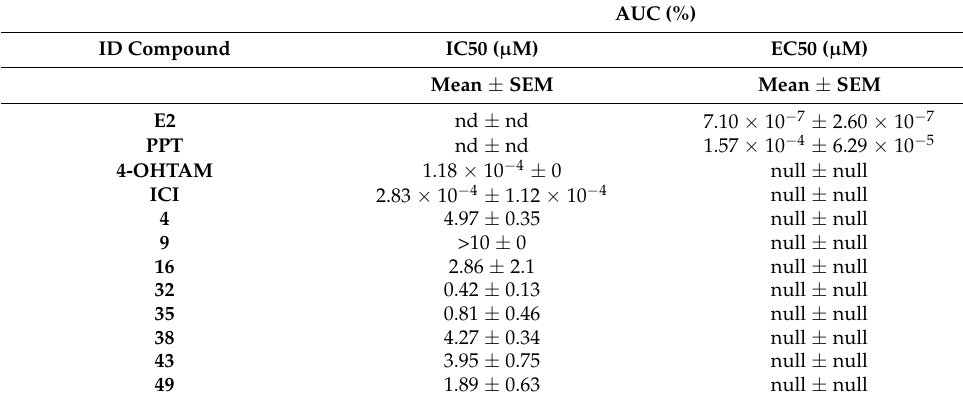
Table 4. Effects of 5-hydroxy-3,5-diaryl-1,5-dihydro-2 H -pyrrol-2-ones on E2-induced proliferation of ER+ breast cancer cells. T47D estrogen-depleted cells were treated with vehicle (VEH, 0.05% DMSO), compounds (0.01–10 µ M), ICI 182,780 (ICI, 0.03–10 nM), 4-hydroxy-tamoxifen (4-OHTAM, 0.01–10 nM) or 1,3,5-tris(4-hydroxyphenyl)-4-propyl-1 H -pyrazole (PPT, 0.01–3 nM) in the absence (+VEH) or presence of E2 (0.1 nM) for 10 days. Cell growth kinetics were calculated by the area